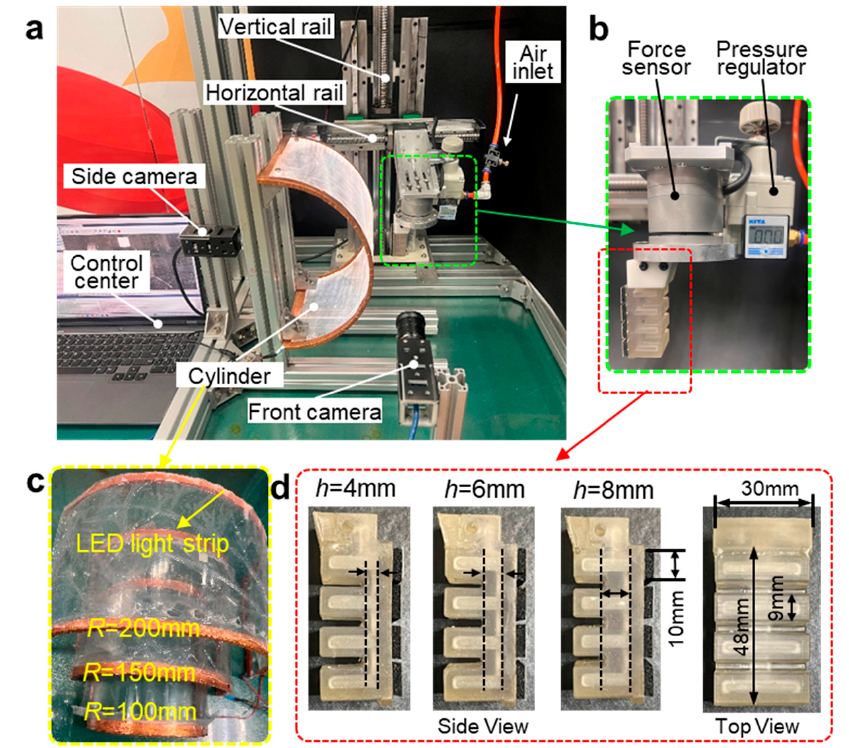
Figure 3. Experimental setup. ( a ) The synchronous testing platform. ( b ) Assembly layout of the SPAA, the six-dimensional force sensor and the pressure regulator. ( c ) Three acrylic semi-cylinders with radii of 100 mm, 150 mm and 200 mm. ( d ) Three SPAA samples prepared by 3D printing and their structural parameters.